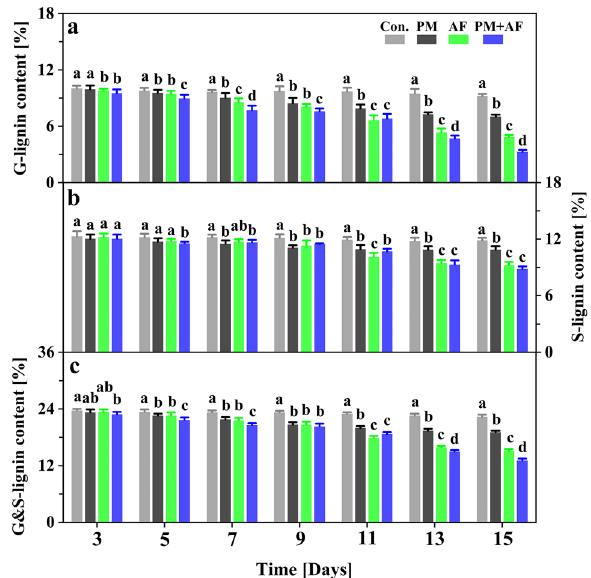
Figure 2. Temporal variations in the content of ( a ) guaiacyl monolignol (G-lignin), ( b ) syringyl monolignol (S-lignin), and ( c ) the sum of the two monolignols (G&S-lignin) in the degradation residues during the 15-day experiments, with measurements at 2-day intervals. Experiments: Con., uninoculated control; PM, Pseudomonas mandelii ; AF, Aspergillus fumigatus ; PM + AF, co-culture of the two microbes. Bars on a given date labelled with different letters differ significantly ( P < 0.05) between the four treatments.